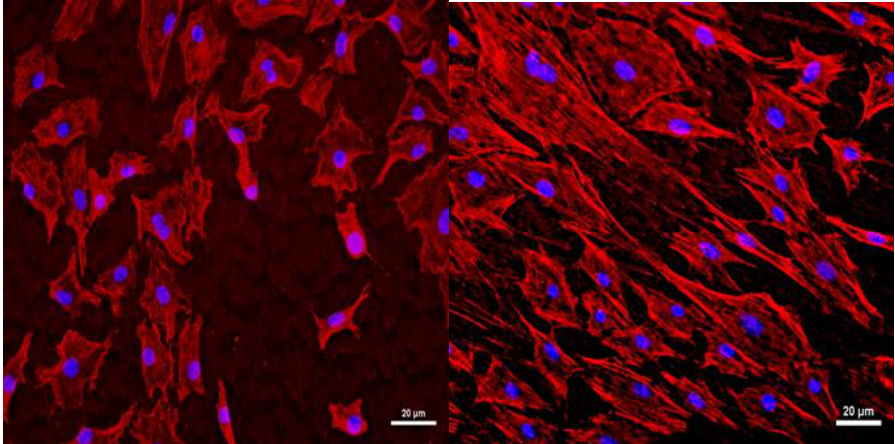
Figure 8. Cell morphologies on the surfaces of plates: untreated titanium plate ( left ) and titanium plate treated with amine plasma ( right ). Nuclei color is blue. treated with amine plasma ( right ). Nuclei color is blue.